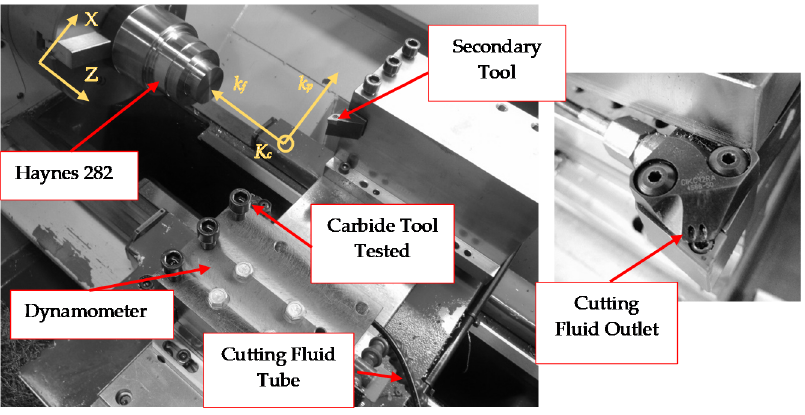
Figure 2. Experimental setup.